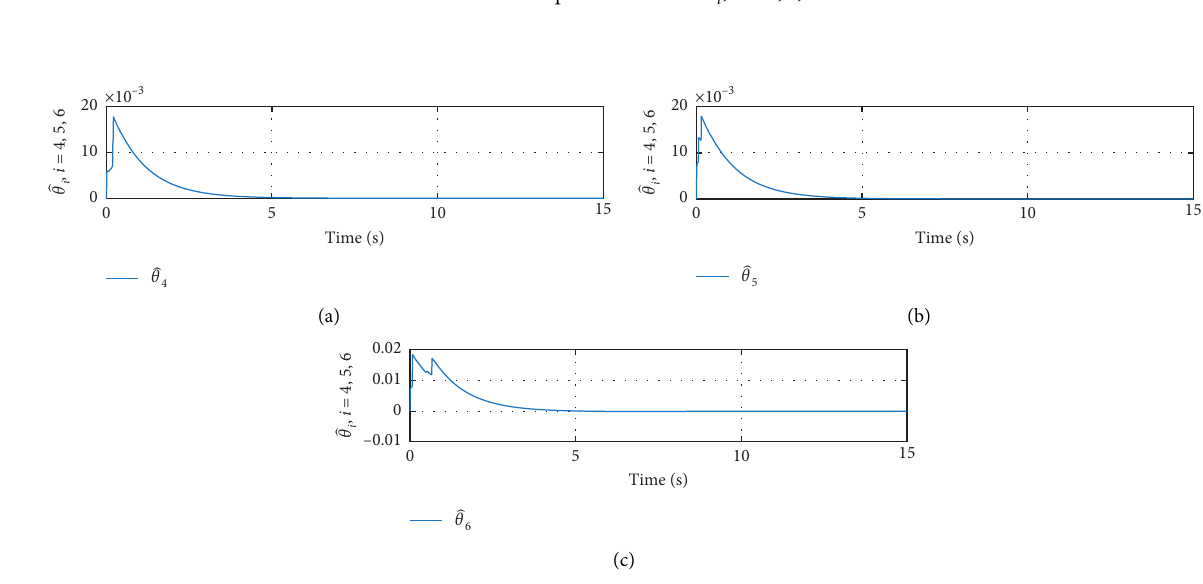
Figure 5: Response curves of 􏽢 θ